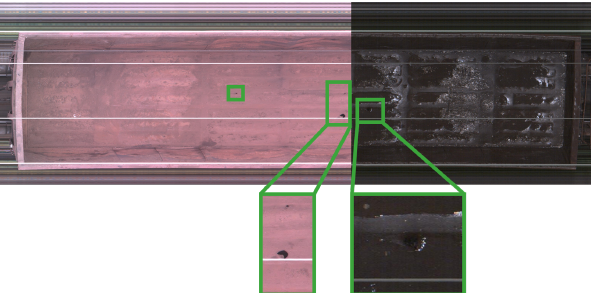
Figure 5. Top view image with sheet metal flooring damage examples.